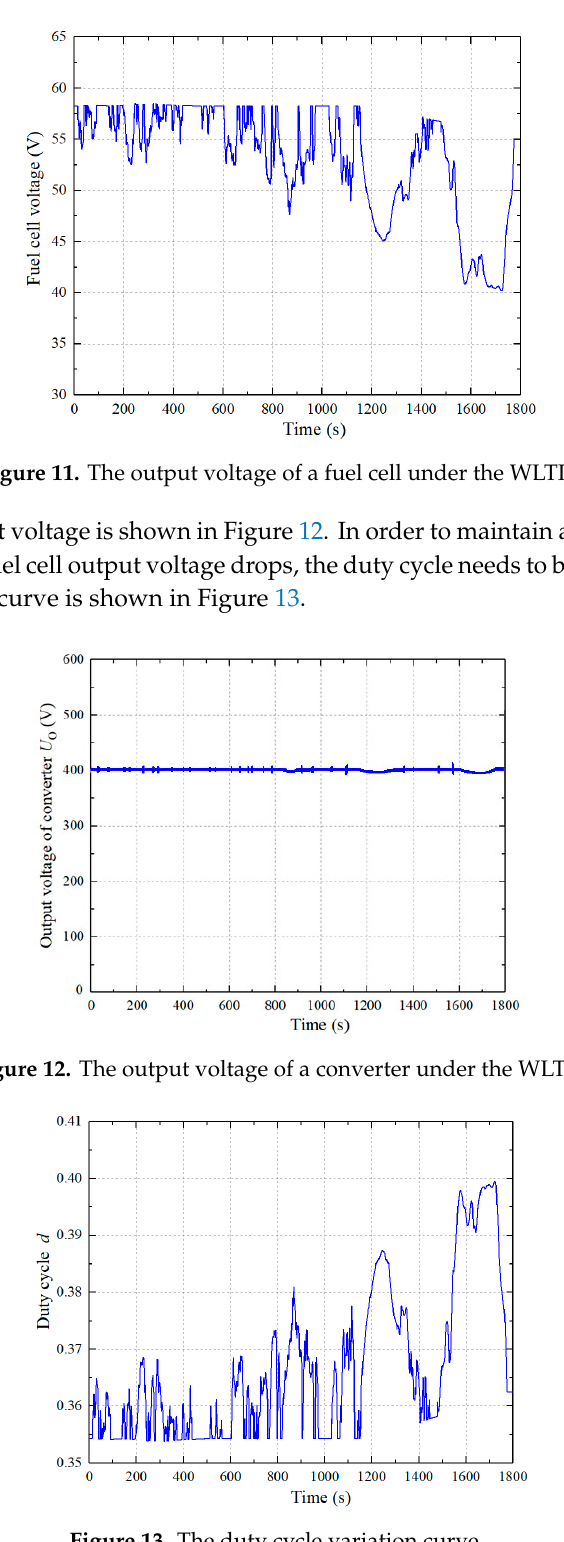
Figure 10. The fuel cell output current under the WLTP.